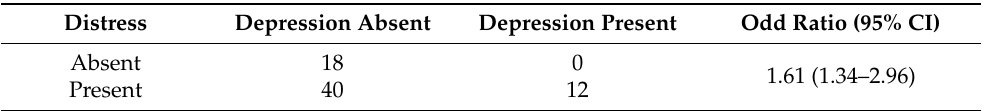
Table 4. Diabetes distress and depression relationship based on the Beck Depression Inventory (BDI) and Diabetes Statistics Manual (DSM) in nondepressed patients.